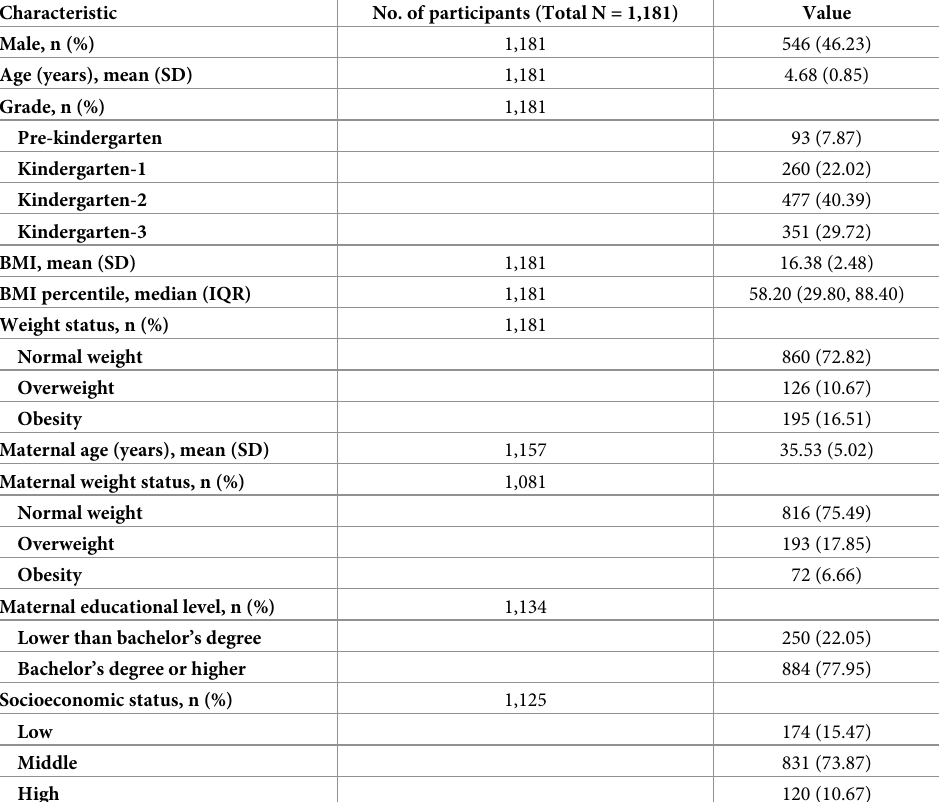
Table 1. General characteristics of the study